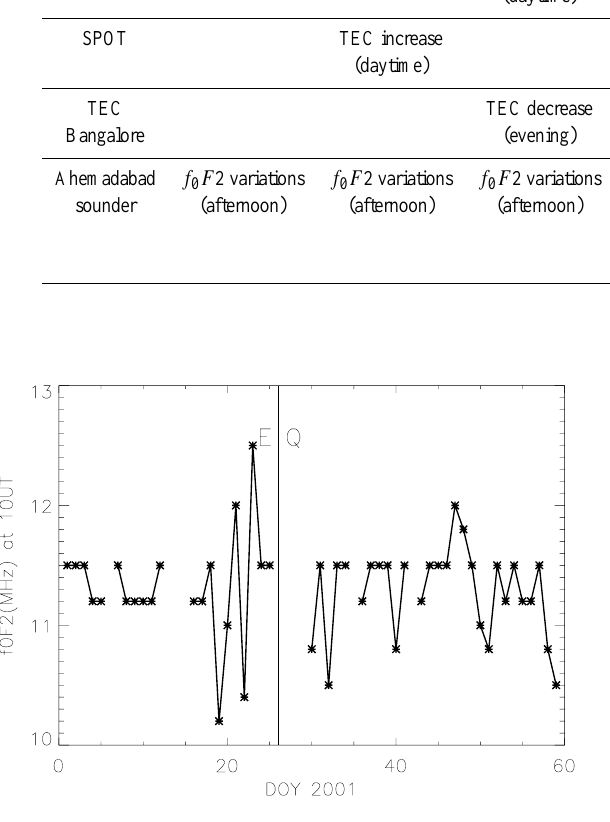
Fig. 8. Critical frequency variations at 10:00UT for January and February 2001 at Ahmadabad ionospheric station.